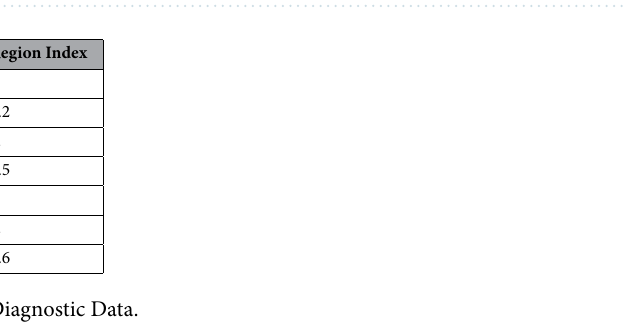
Figure 1. Five Regions in Malaysia (generated using Tableau version 2020.3.2) (https:// www. table au. com/ suppo rt/ relea ses/ deskt op/ 2020.3.2).